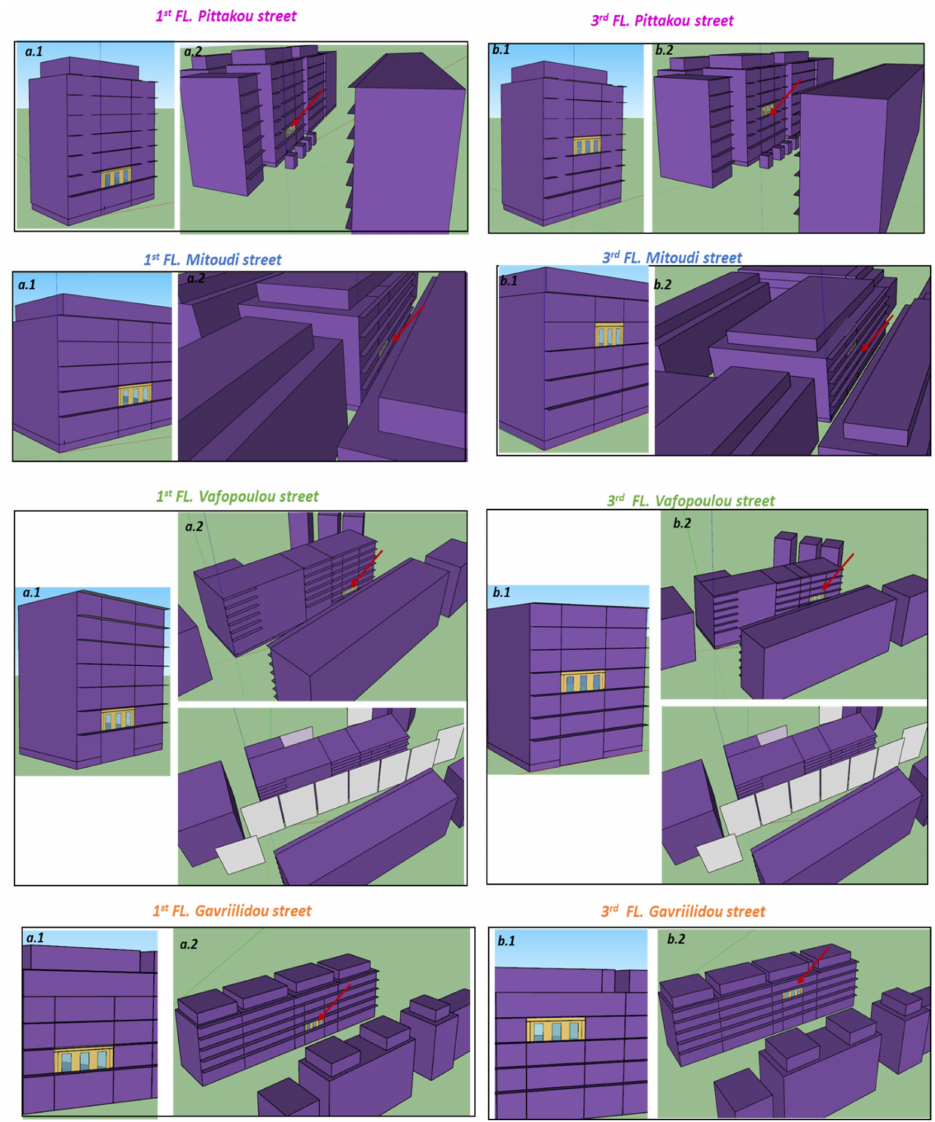
Figure 7. Indication of the location of the investigated building units in the building ( a.1 , b.1 ) for the 1st and 3rd floor building units, respectively) and position of the surrounding building obstacles ( a.2 , b.2 ) for the 1st and 3rd floor building units,